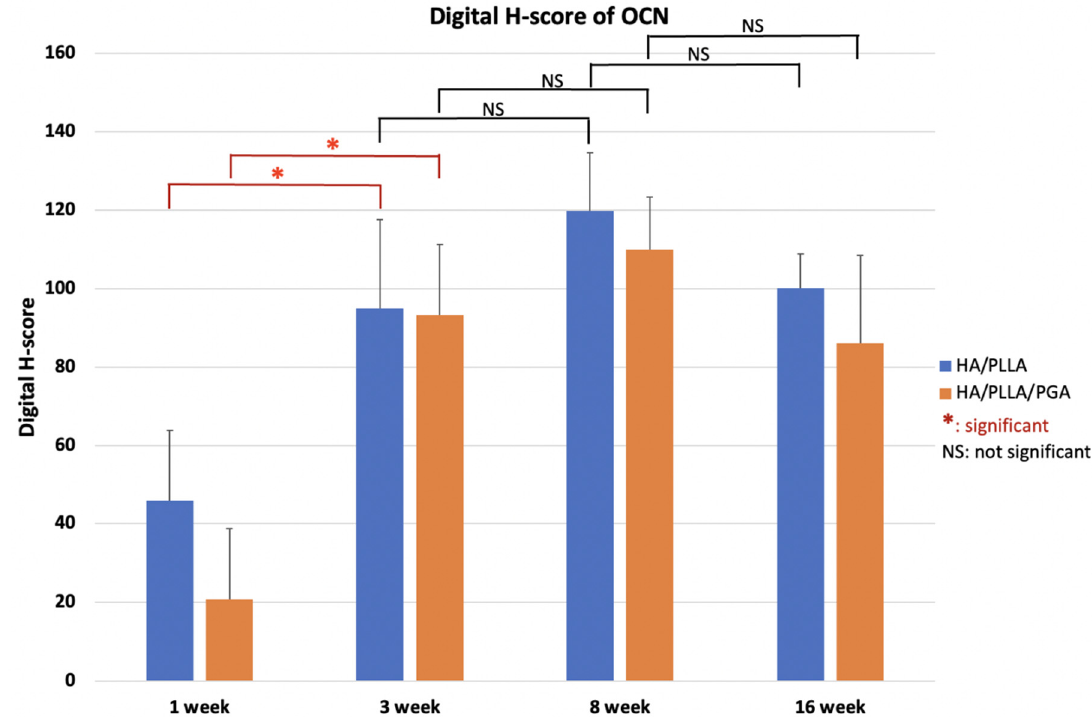
Figure 16. Digital H-scores based on IHC staining with anti-OCN antibody in the u-HA/PLLA and u-HA/PLLA/PGA groups. * p < 0.05.